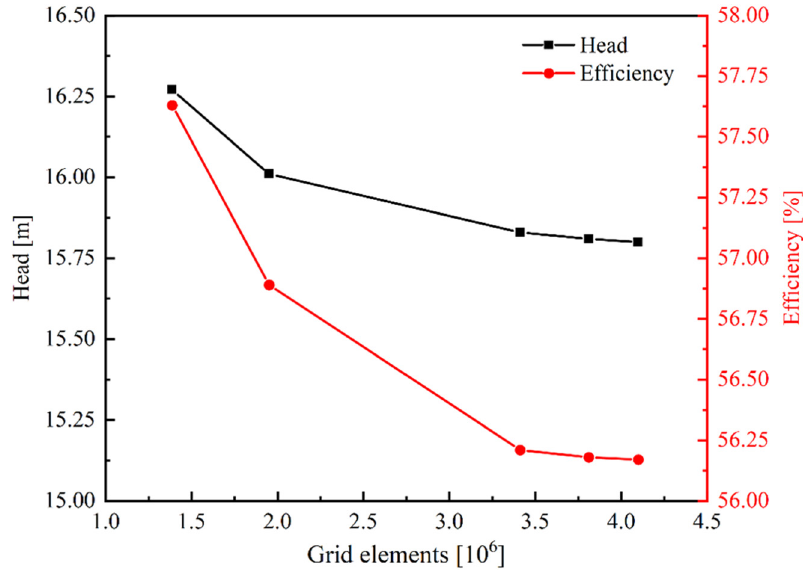
Figure 4. Verification of rid independence.